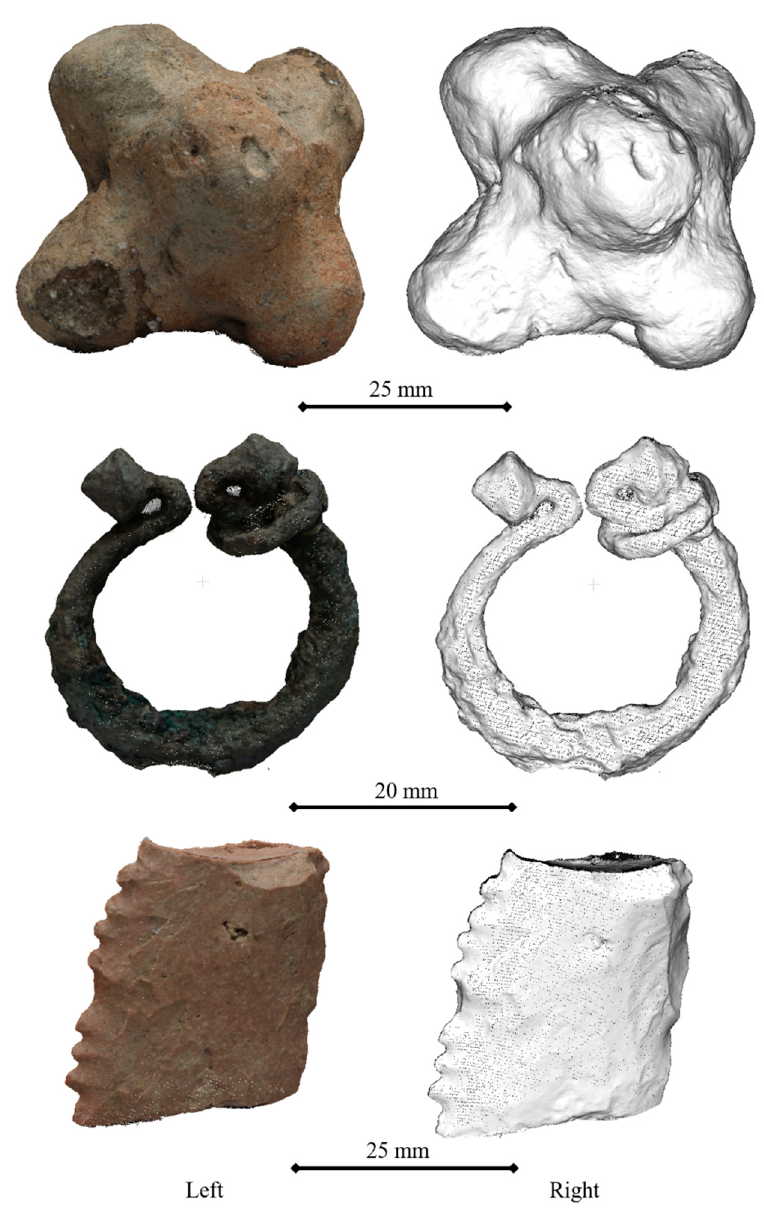
Figure 5. Dense 3D point clouds with texture ( left ) and without texture ( right ), generated using a pre-calibrated zoom lens.